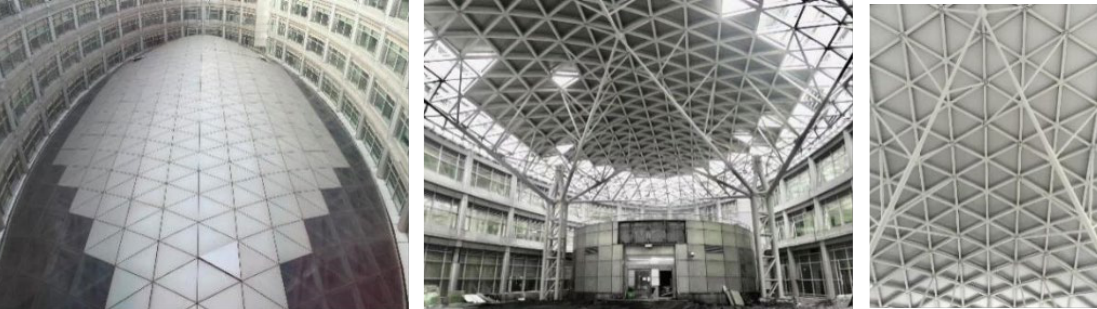
Figure 15. Photos of the completed project.